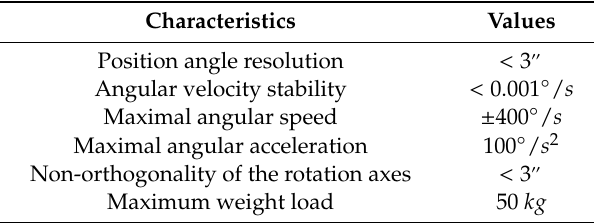
Table 2. Specifications of dual-axis turntable.